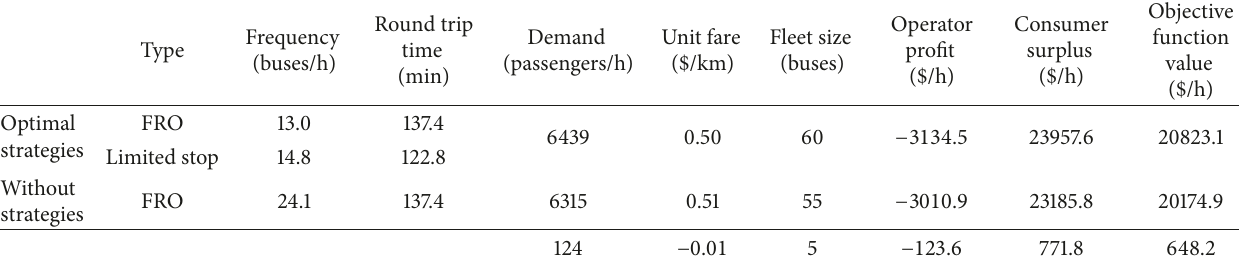
Table 5: Results of two objectives with and without optimal strategies based on a differential fare